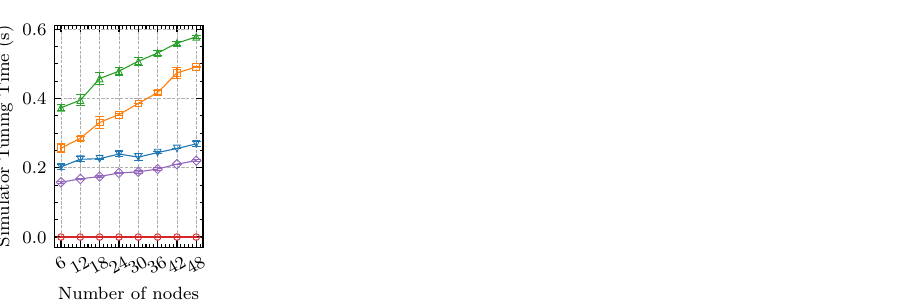
Figure 5. Scalability Analysis of SimTune and baselines with different number of nodes in the edge-cloud setup.